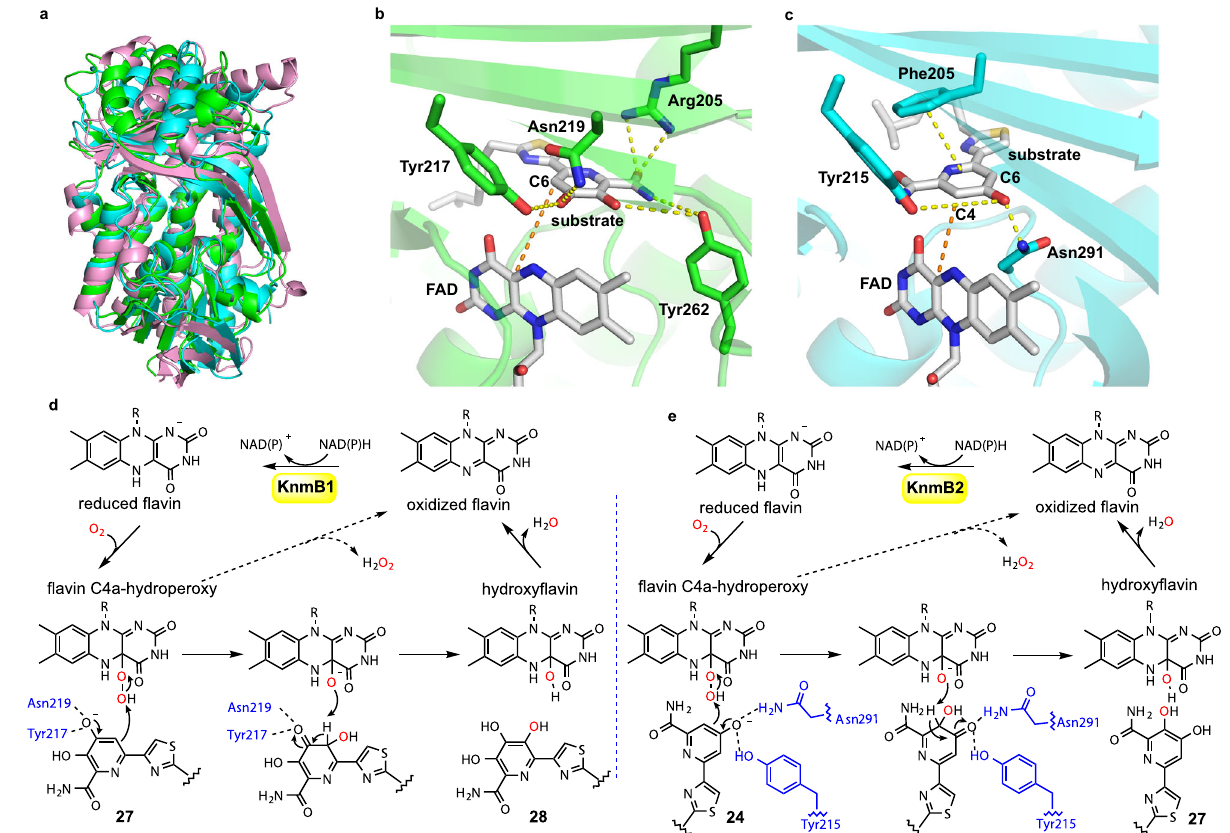
Fig. 5 | Structures and catalytic mechanisms of KnmB1 and KnmB2. a Comparison of the overall structures of KnmB1 (green), KnmB2 (cyan), and p - hydroxybenzoate hydroxylase (PHBH; pdb:1pbe; pink). b Molecular docking of 27 inKnmB1. c Moleculardockingof 24 inKnmB2.N,O,andSatomsarecoloredblue,